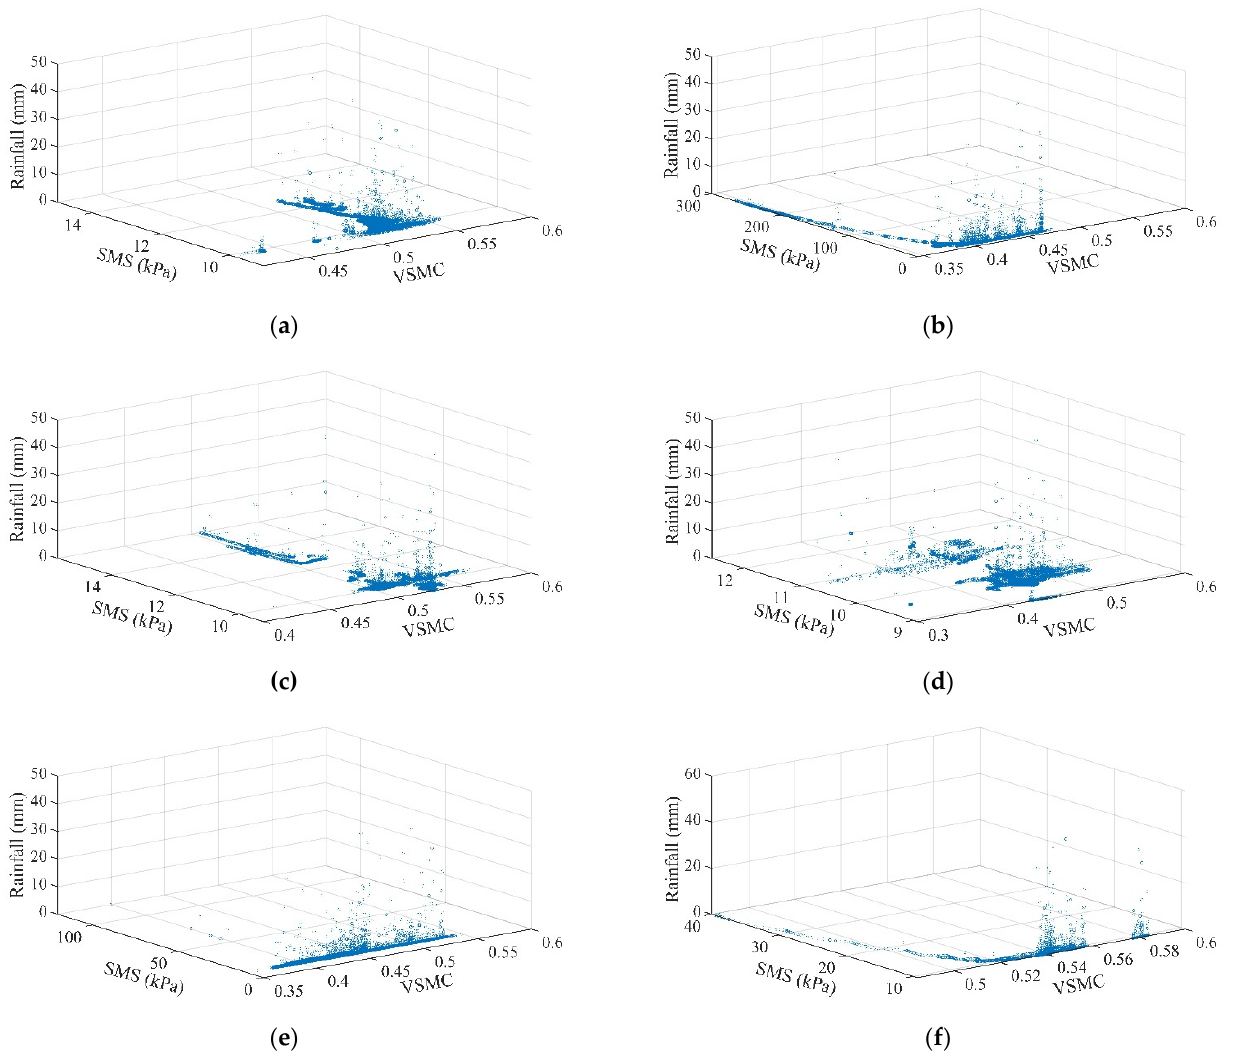
Figure 4. 3D in situ variation of rainfall, SMS, and VSMC at 1.5 m depth ( a ) HWS 1 ( b ) HWS 2 ( c ) HWS 3 ( d ) HWS 4 ( e ) HWS 5 ( f ) HWS 6.